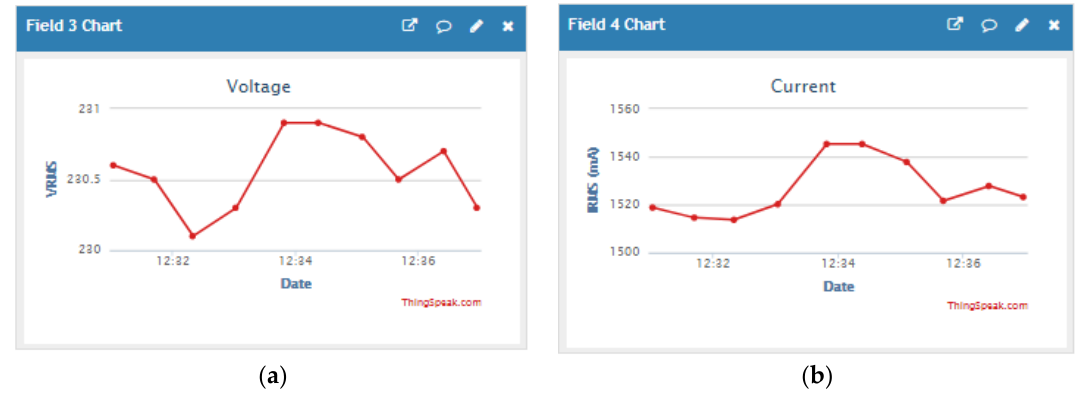
Figure 14. ( a ) V RMS ( b ) I RMS uploaded in ThingSpeak.